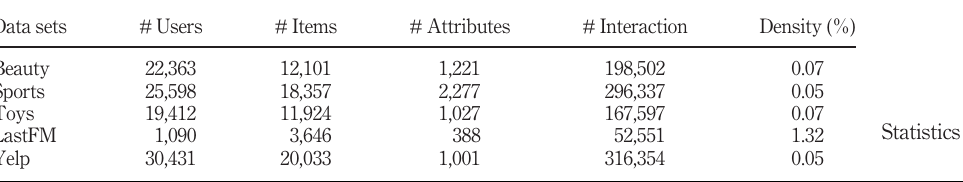
Table 1. Statistics of the data